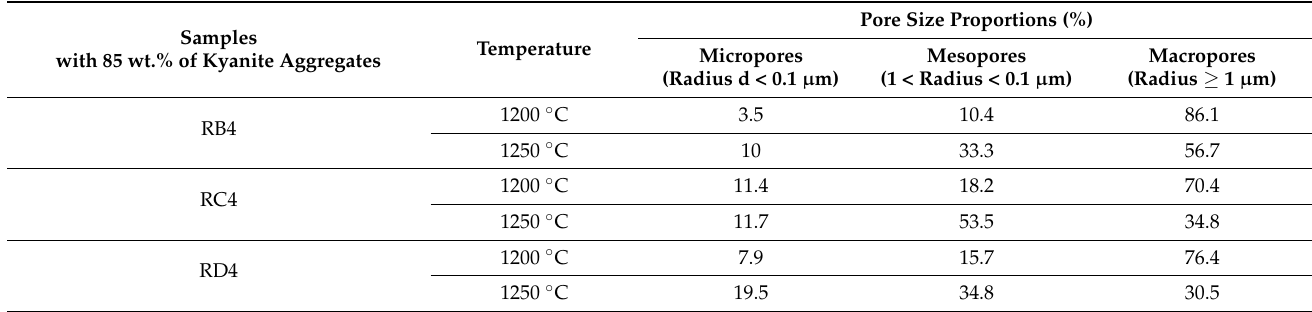
Table 3. Types of pores of selected refractory geopolymer composites after exposures at 1200 and 1250 ◦ C. Samples with 85 wt.% of Kyanite Aggregates